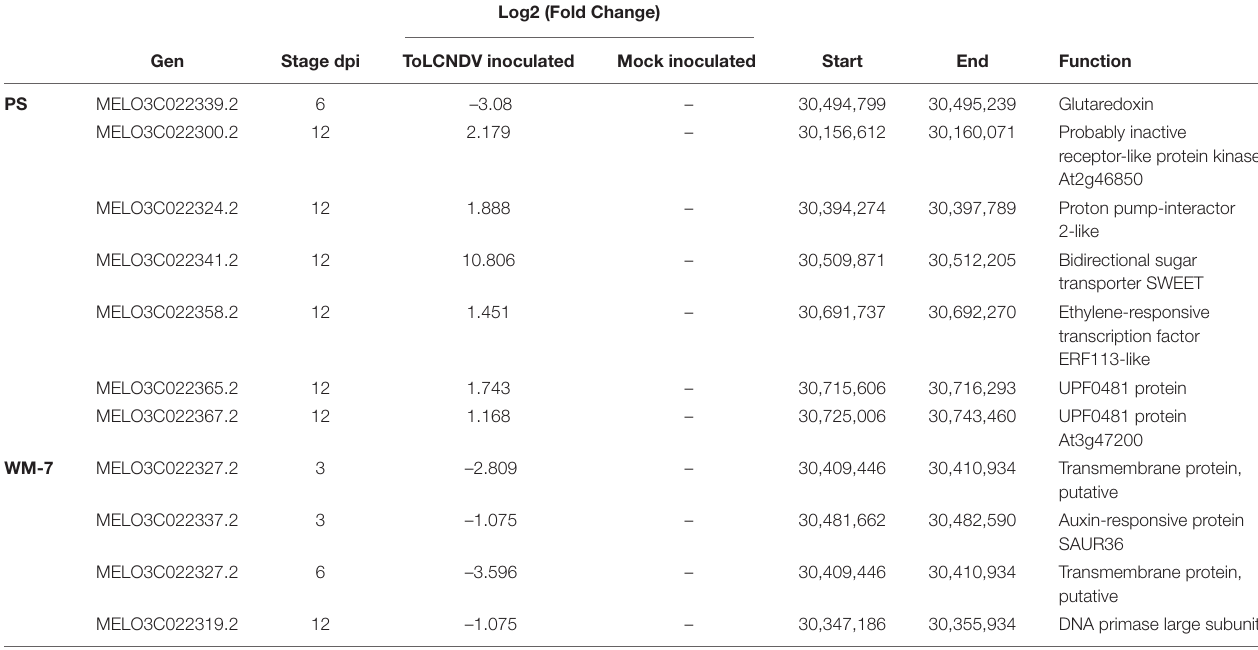
TABLE 2 | Differentially expressed genes in the candidate region for ToLCNDV resistance of C. melo chromosome 11. Log2 (Fold Change) Gen Stage dpi ToLCNDV inoculated Mock inoculated Start End